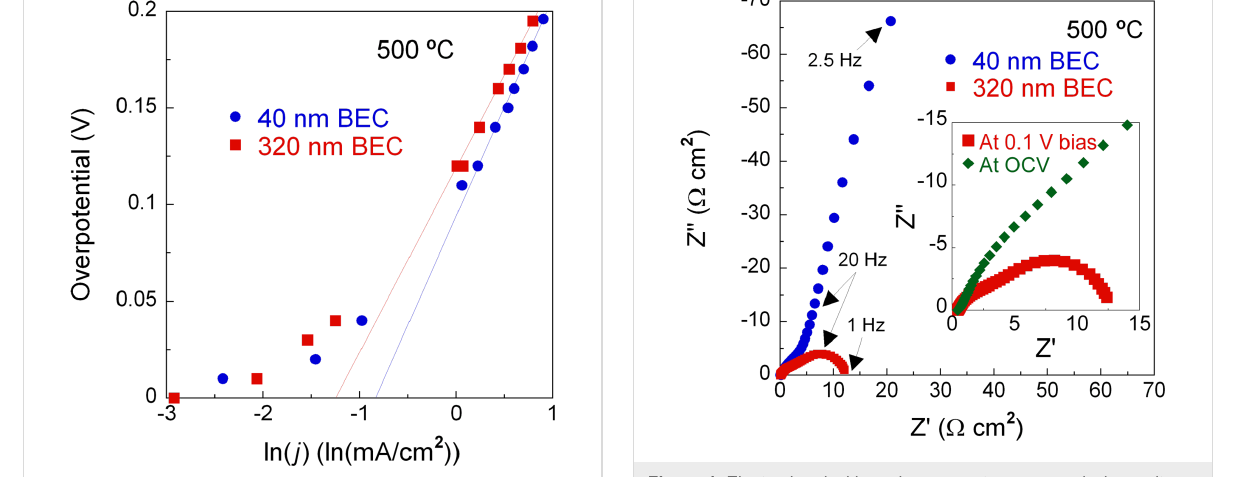
Figure 4: Electrochemical impedance spectroscopy analysis results, measured at 500 °C, at bias voltage of 0.1 V for the Cell-A and Cell-B, and (inset) at open circuit voltage and bias voltage of 0.1 V for the